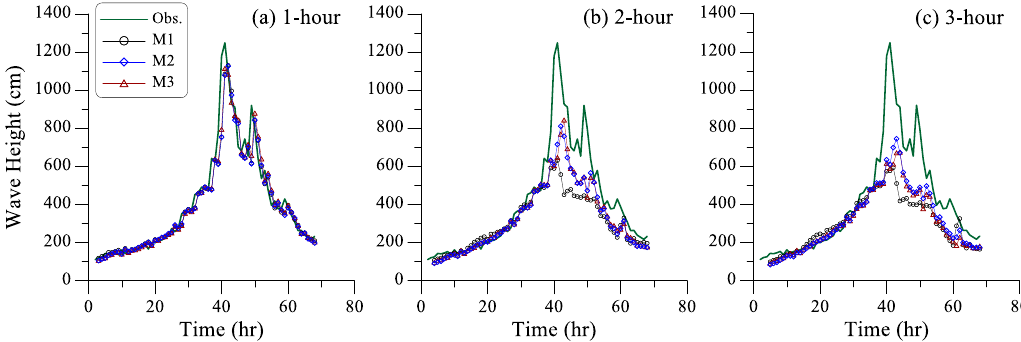
Figure 8. Real-time wave height forecasting with lead time of ( a ) 1, ( b ) 2, and ( c ) 3 h for Event 17 at Longdong.